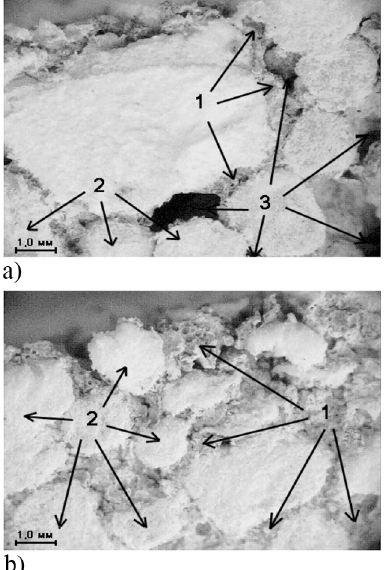
Fig. 5. The surface morphology of lightweight composite of 3 density: a – unstrained; b – strained under load. 250–350 kg/m